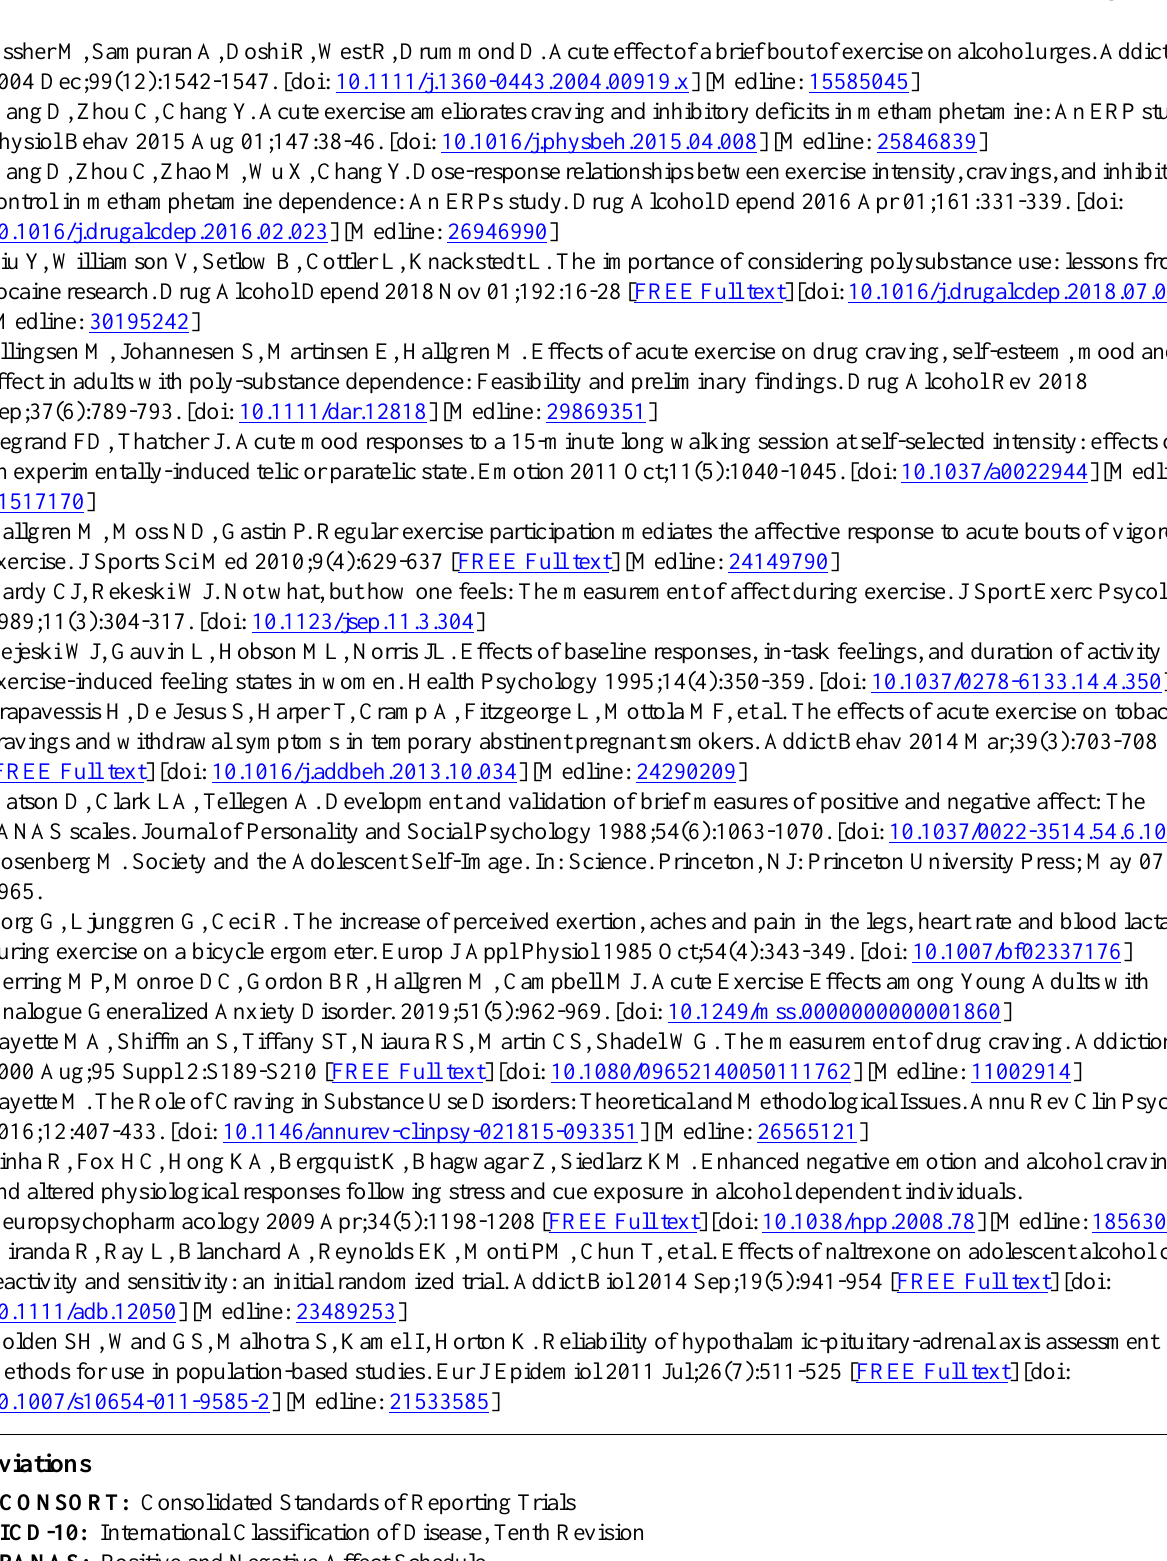
PANAS: Positive and Negative Affect Schedule SPIRIT: Standard Protocol Items: Recommendations for Interventional Trials SUD: substance use disorder VAS: visual analog